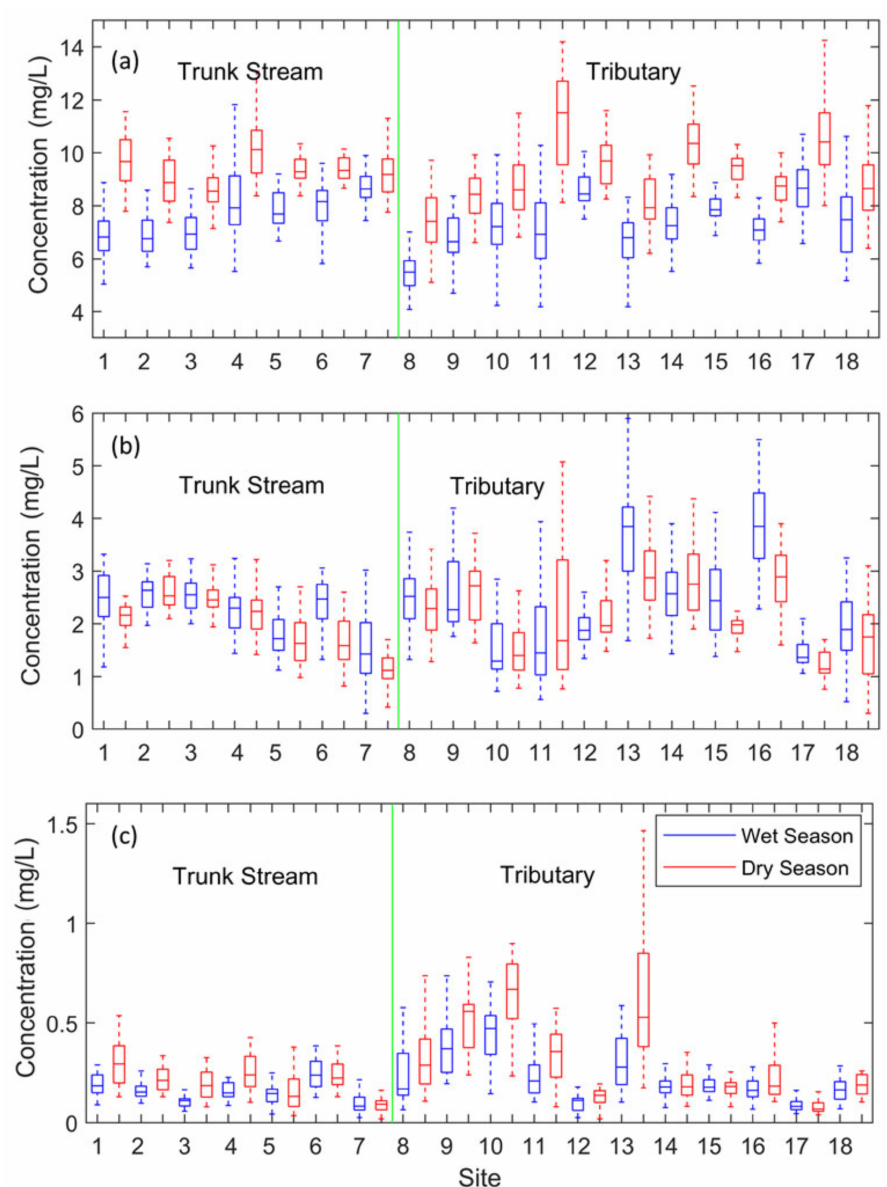
Figure 3. Box plots of water quality concentration of DO ( a ) COD Mn ( b ), and NH 3 -N ( c ) in the wet and dry seasons. The X-axis represents water quality stations, and the positive directions along the X-axis indicate an increase in the distance from the site to the estuary. The left side of the green line is the main stream, and the right side is the